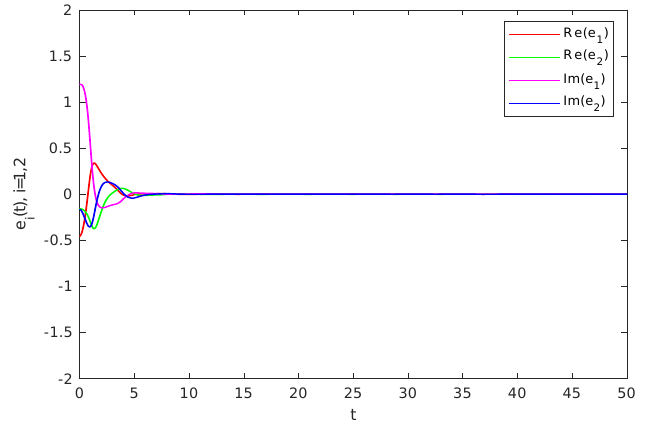
Figure 11. Time evolution of synchronization errors e 1 ( t ) and e 2 ( t ) under the adaptive controller